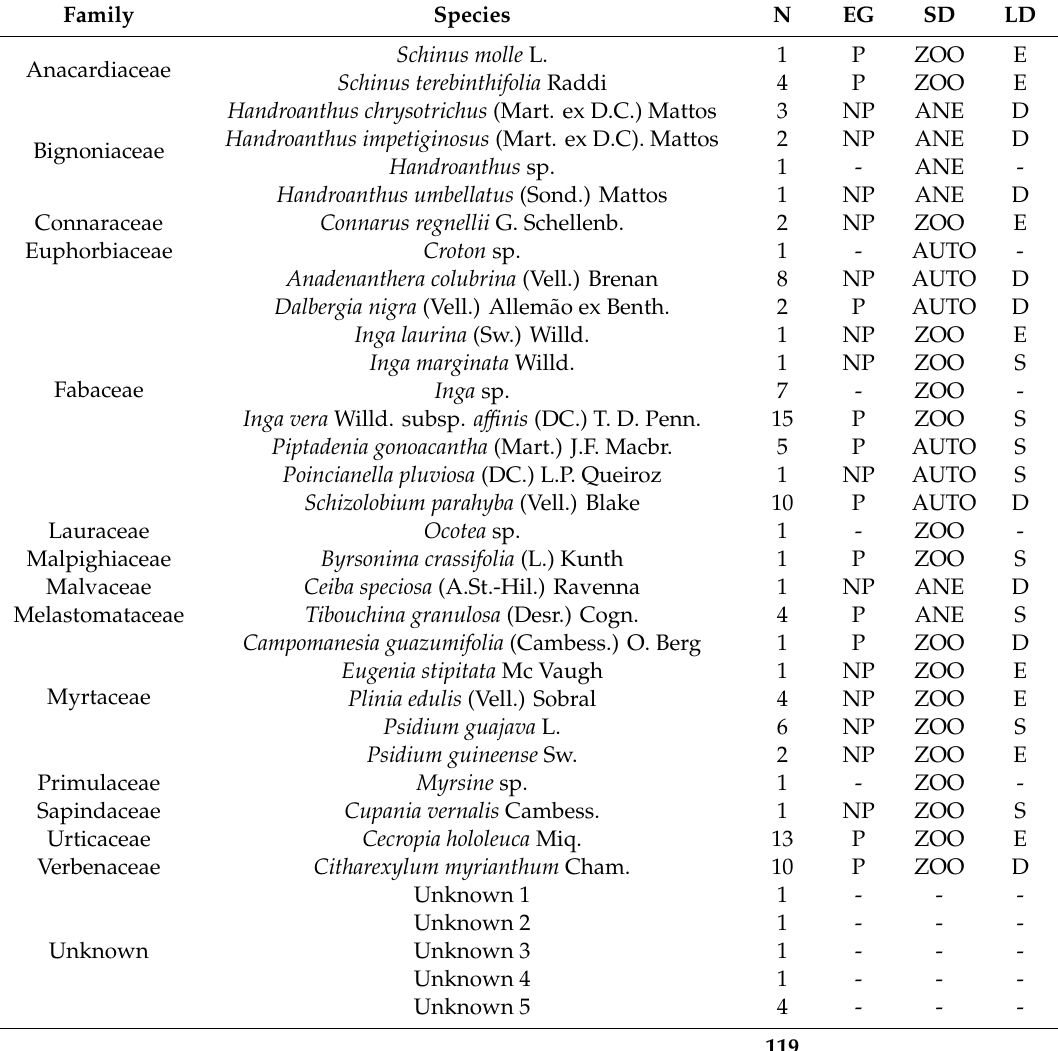
Table 1. List of the studied species, containing the number of sampled individuals (N); the ecological group (EG)—pioneers (P) and non-pioneers (NP); the dispersal syndrome (SD)—anemochoric (ANE), autochoric (AUTO), and zoochoric (ZOO); and the leaf deciduousness (LD)—deciduous (D), evergreen (E), and semi-deciduous